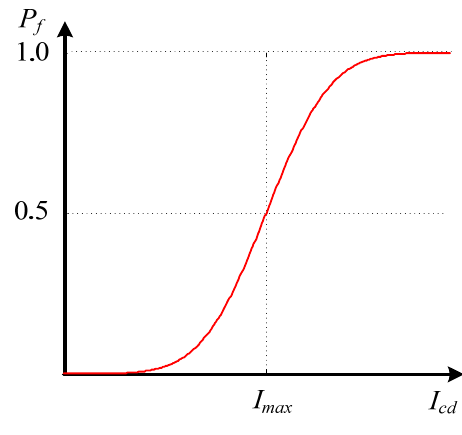
Figure 4. False trip probability caused by the differential